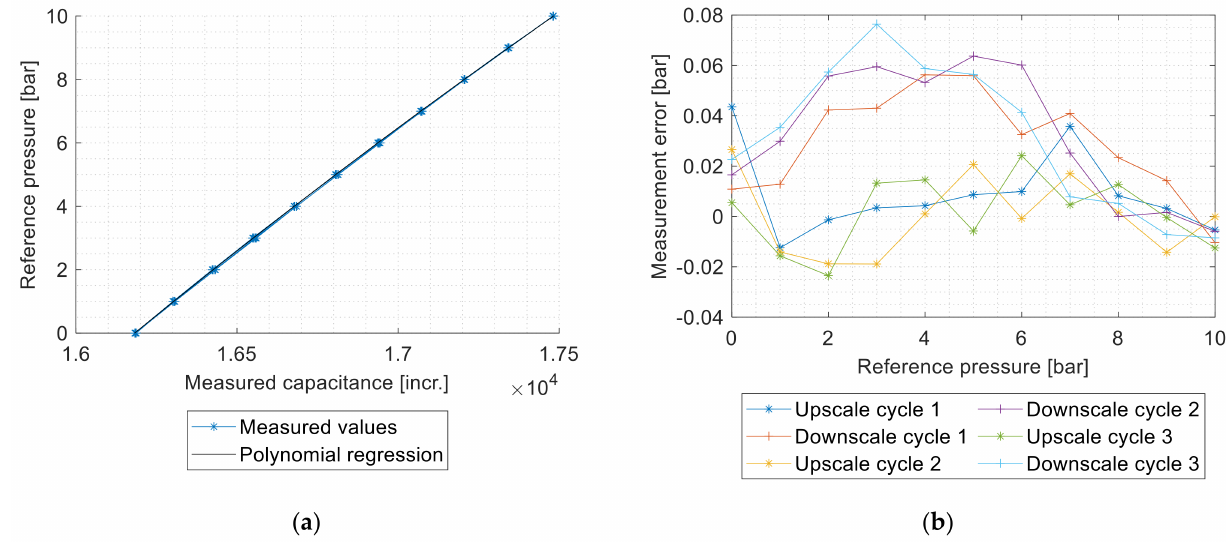
Figure 10. Measurement result. ( a ) Characteristic curve with polynomial regression: the measured values were fitted with a second-order polynomial approximation to calibrate the values and to obtain the measured pressure values. ( b ) Error curve: the measured values for upscale and downscale cycles are shown separately, so that a possible hysteresis can be